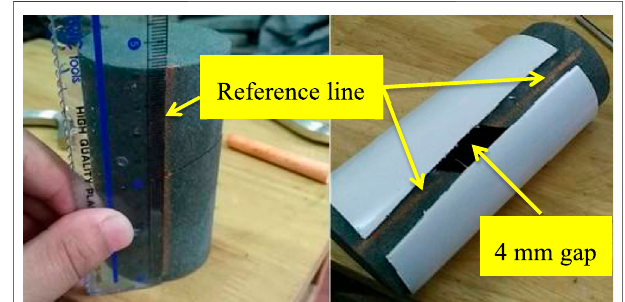
FIGURE 2 | Molding and